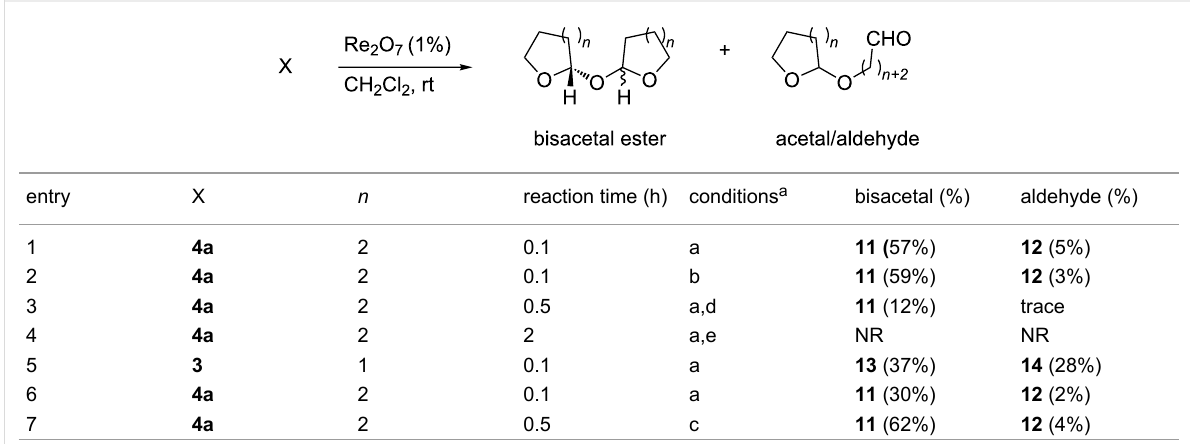
Table 3: Dimerization of